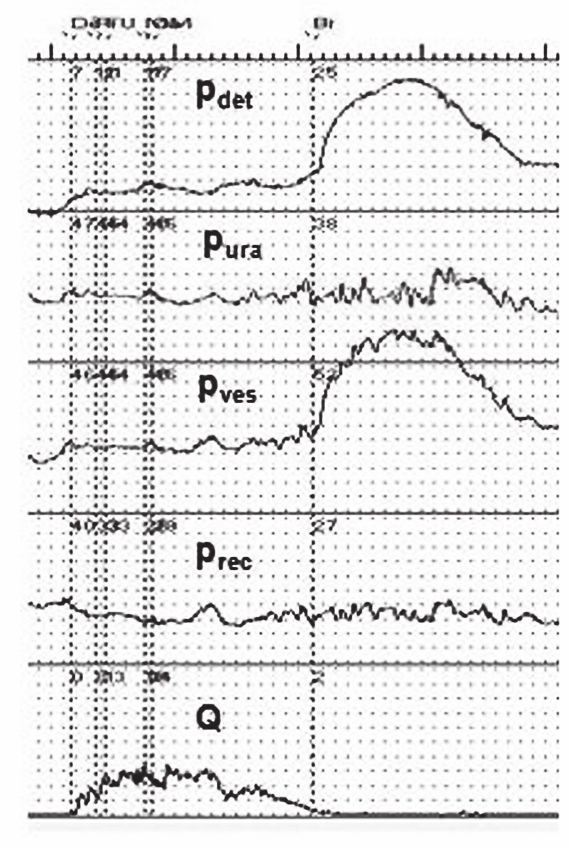
Figure 1 - Recording of a typical example of detrusor after-contraction (DAC) observed during intubated flow of a female patient. From top to bottom: detrusor pressure (p ), urethral pressure (p ), vesical pressure (p ), rectal det ura ves pressure (p ) and flow rate (Q). Note the high amplitude of rec DAC compared with pdet during